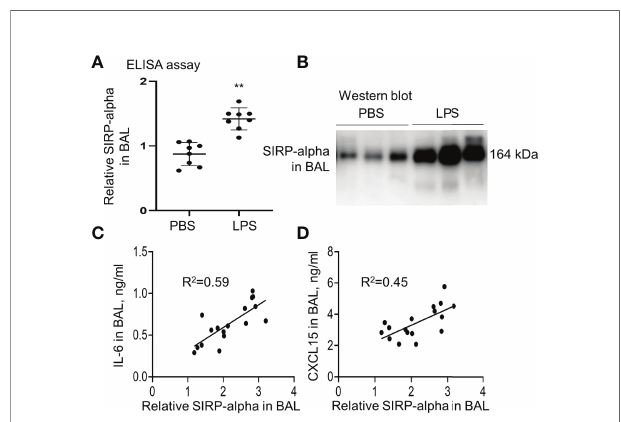
FIGURE 1 | The expression level of SIRP-alpha was increased in BAL of mice with LPS-induced acute lung injury (ALI). (A) Direct ELISA assay for soluble SIRP-alpha in BAL of mice with LPS-induced ALI or treated with PBS control. Data was presented as ratio of OD450nm value to PBS control, **p < 0.01 vs. PBS group. 2-tailed student t tests. (B) Western blot analysis for soluble SIRP-alpha protein in BAL. One representative blot. Each lane represents individual sample of each mouse. (C, D) Correlation analysis between the expression levels of soluble SIRP-alpha and IL-6 or CXCL15 in BAL. Each point presents the value of individual